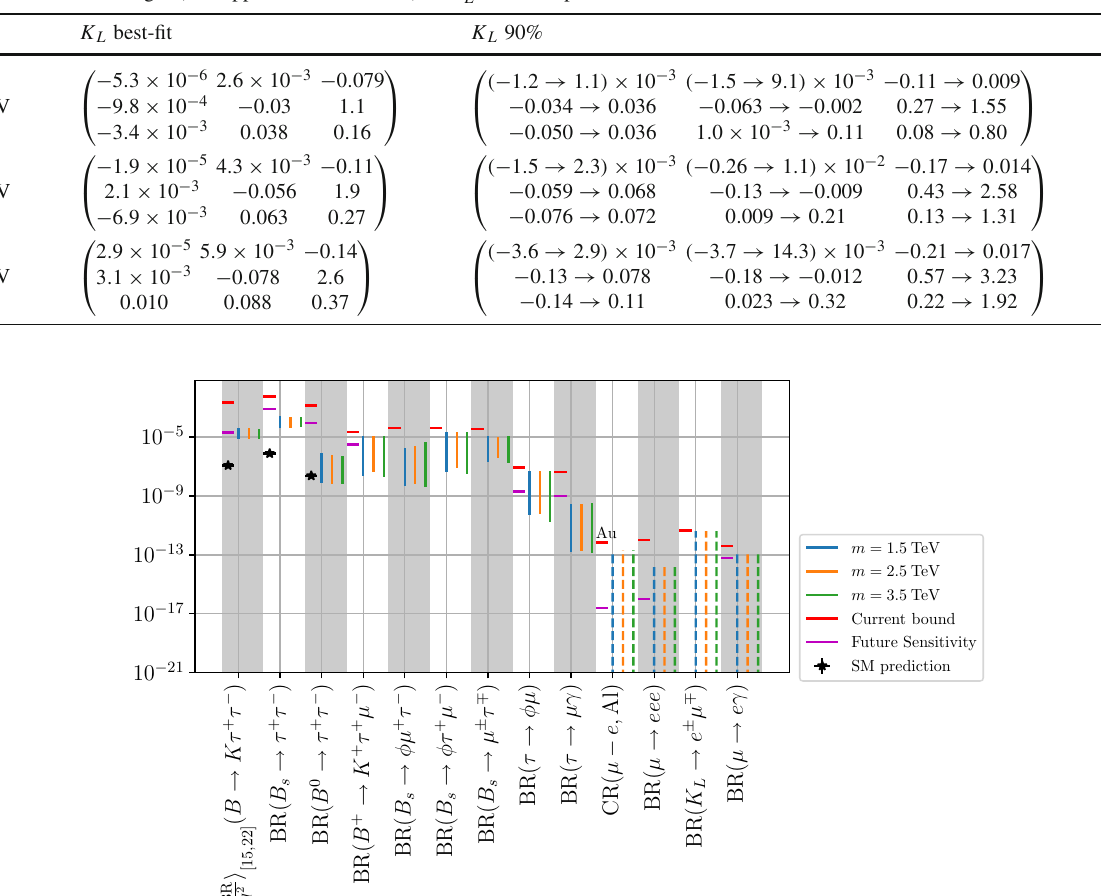
Fig. 3 Predictedrangesforseveral τ -leptonandLFVobservables.The blue, orange and green lines respectively denote the 90% range for lep- toquarkmassesof1 . 5 , 2 . 5 and 3 . 5TeVwhilethehorizontalred(purple) lines denote the current (future) bound at 90% CL; stars denote SM pre-